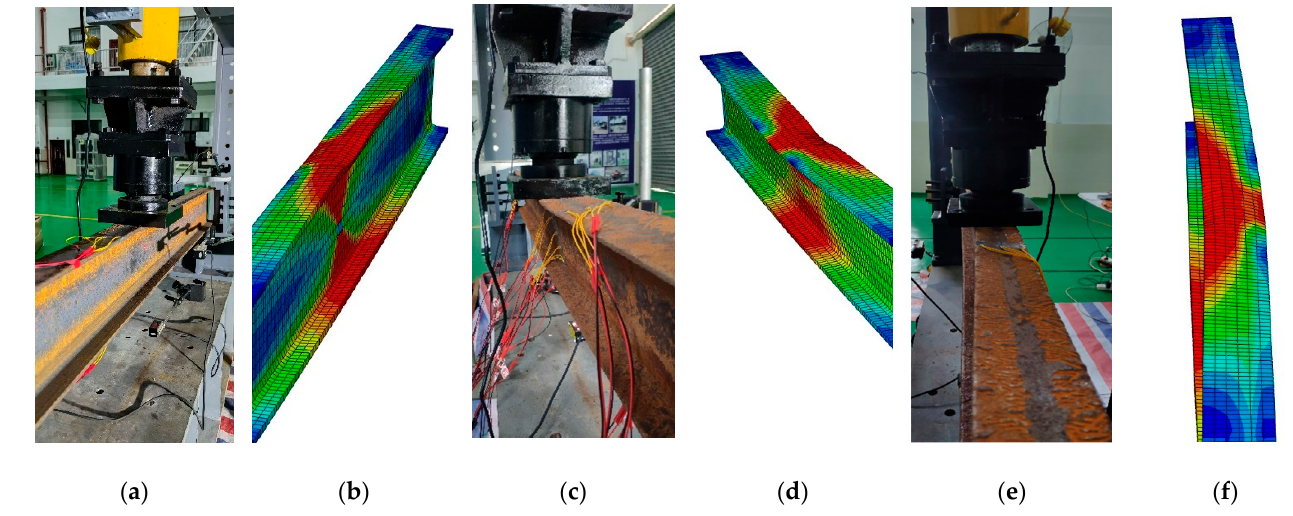
Figure 18. Comparison between the failure modes of specimens: ( a ) Test beam A01; ( b ) Numerical simulation A01; ( c ) Test beam A13; ( d ) Numerical simulation A13; ( e ) Test beam A21; ( f ) Numerical simulation A21.